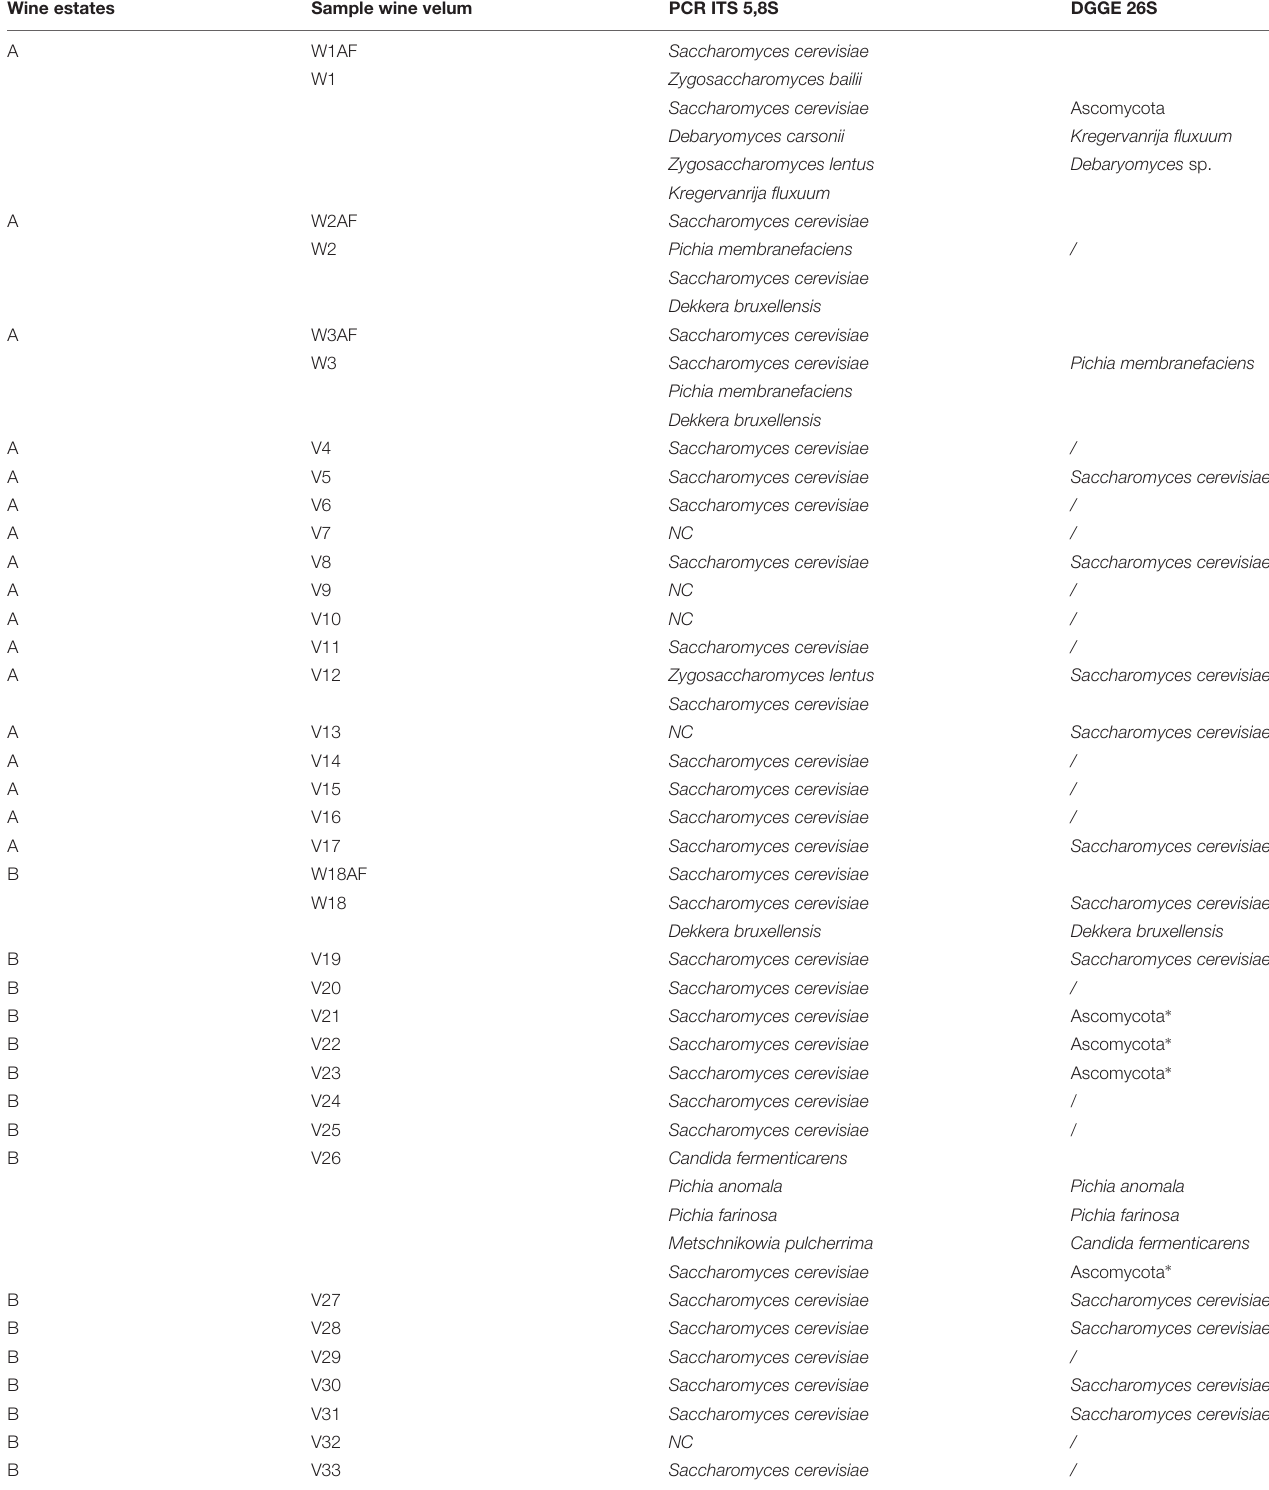
TABLE 1 | Identification of wine and velum yeast by different molecular techniques (5,8S PCR and 26S DGGE). Wine estates Sample wine velum PCR ITS 5,8S DGGE